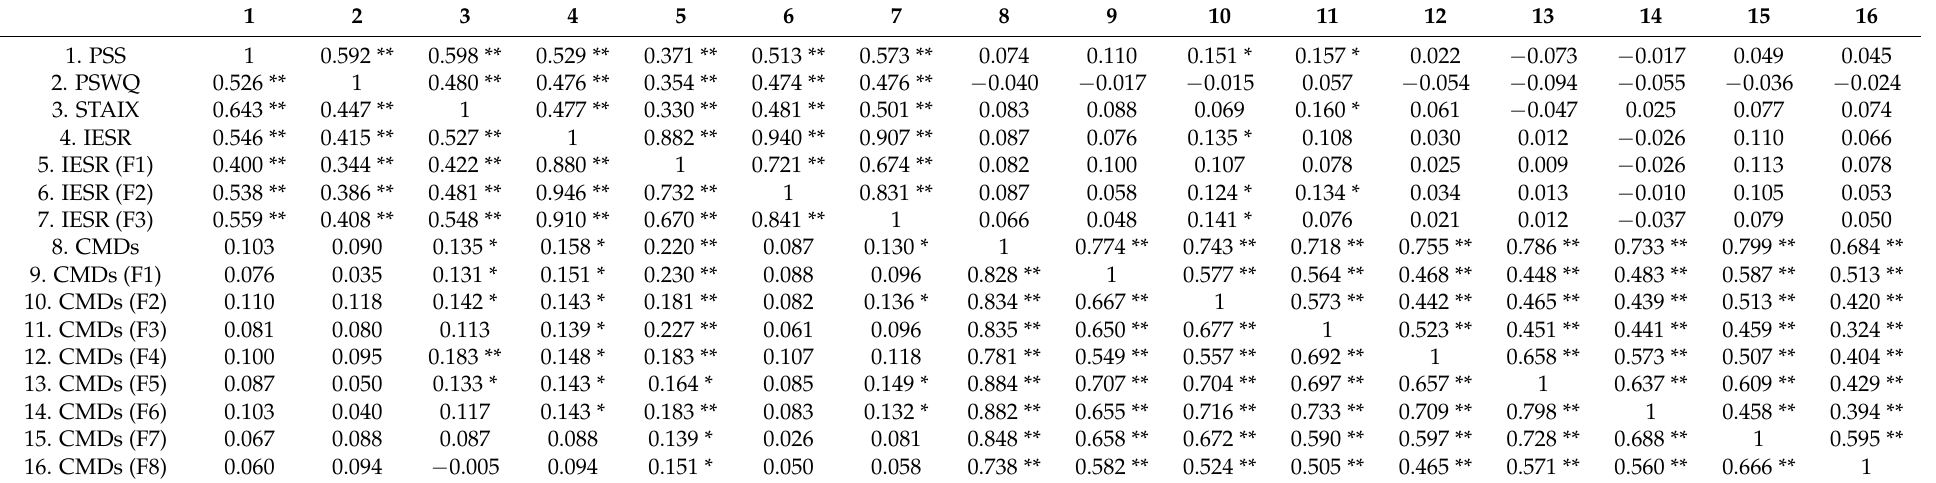
Table 2. Correlation among the variables in November 2020 (T3, over the diagonal) and March 2021 (T4, below the